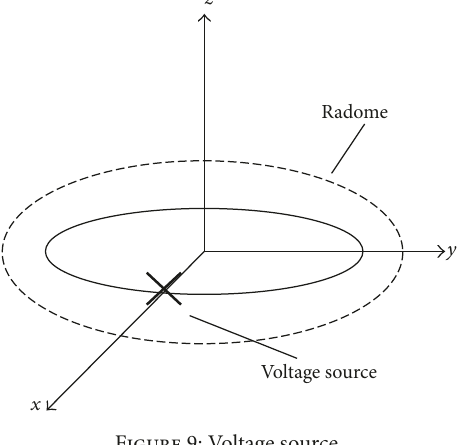
Figure 9: Voltage